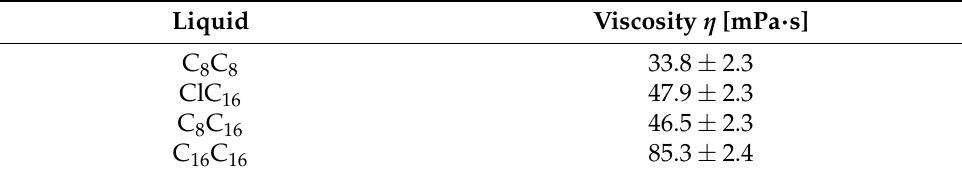
Table 1. Viscosities of four fluorescent liquid derivatives.